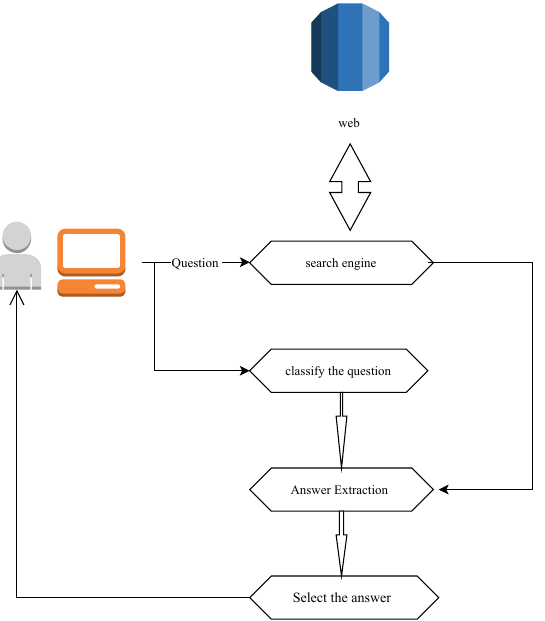
Figure 5. Design of web-based QASs.